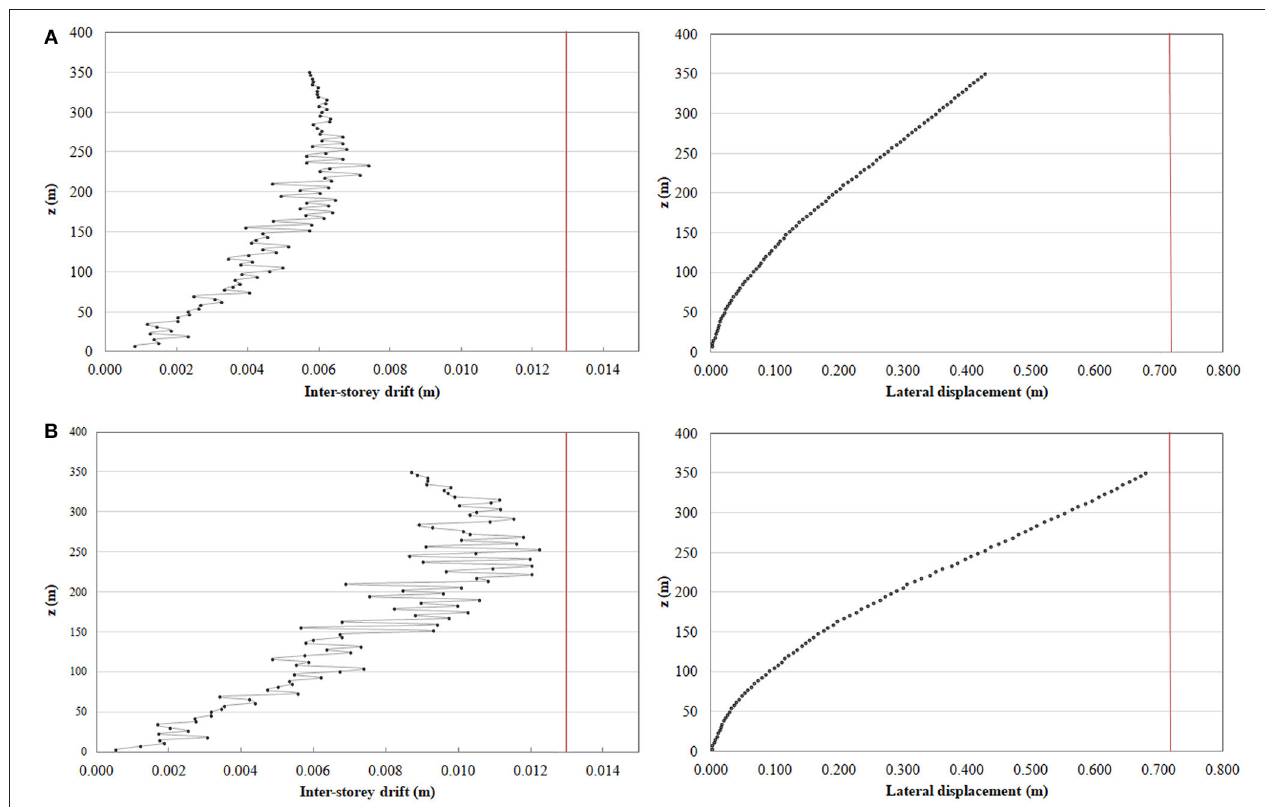
FIGURE 10 | Inter-story drifts (on the left) and lateral displacements (on the right) under wind forces: varying density Voronoi pattern with constant cross-sections (A) and optimized cross-sections (B) .